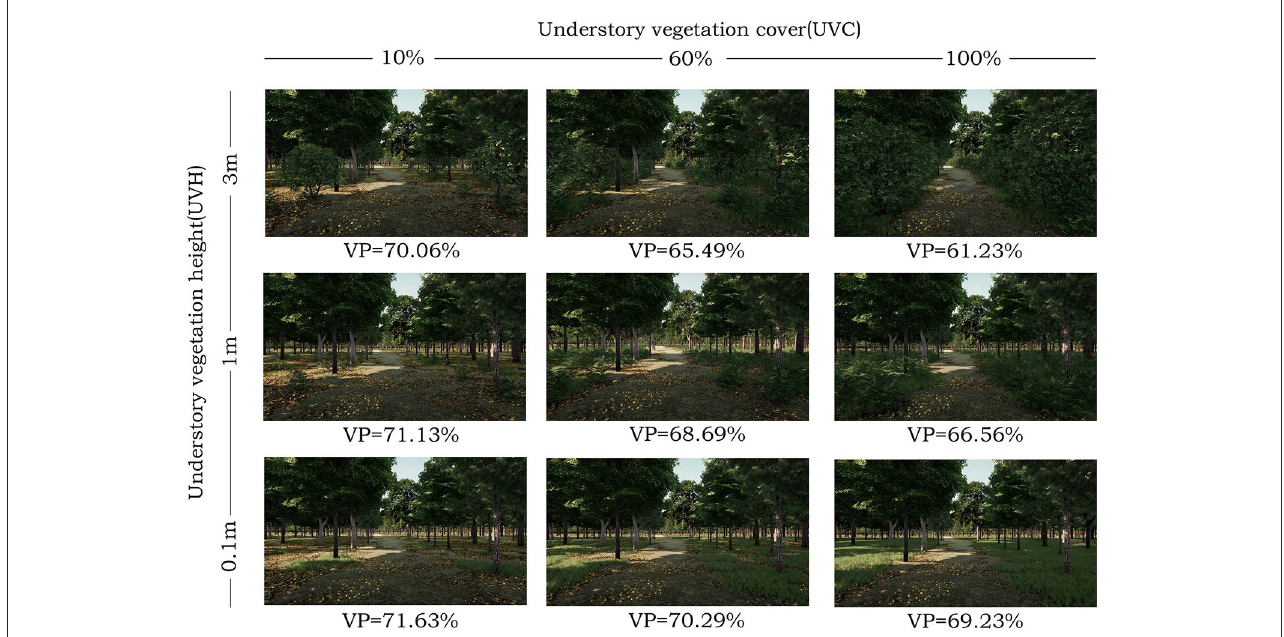
FIGURE2 Research stimulus of broadleaved forest in virtual reality video display. VP, vegetation permeability.